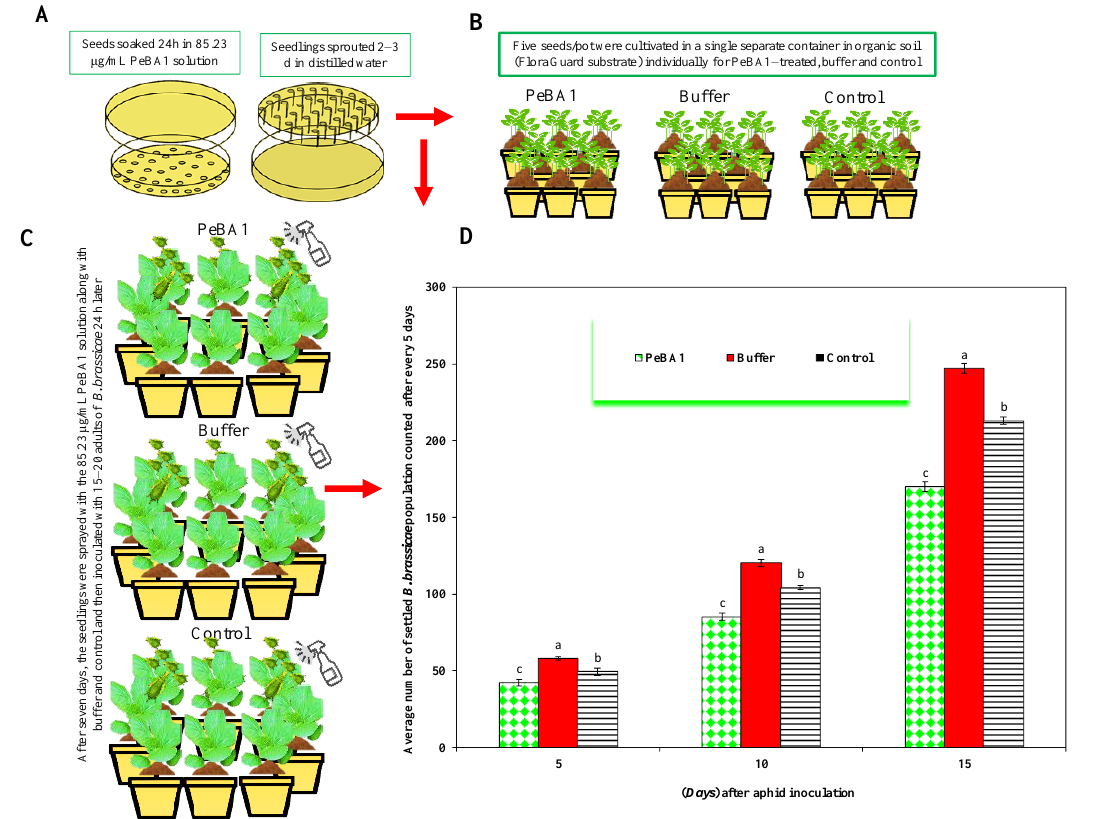
Figure 1. Plants treated with PeBA1, control, and buffer showed B. brassicae population variations. ( A , B ) Seeds and seedling treatment, ( C ) after 7 d, seedlings were inoculated with 15–20 adults of B. brassicae , ( D ) seedlings treated with PeBA1 saw a substantial aphid population loss (mean ± SD), (a–c) the significant differences among PeBA1, buffer and control. The study used a CRD randomized statistical design, LSD and one-way ANOVA were used to compare data ( p = 0.05).